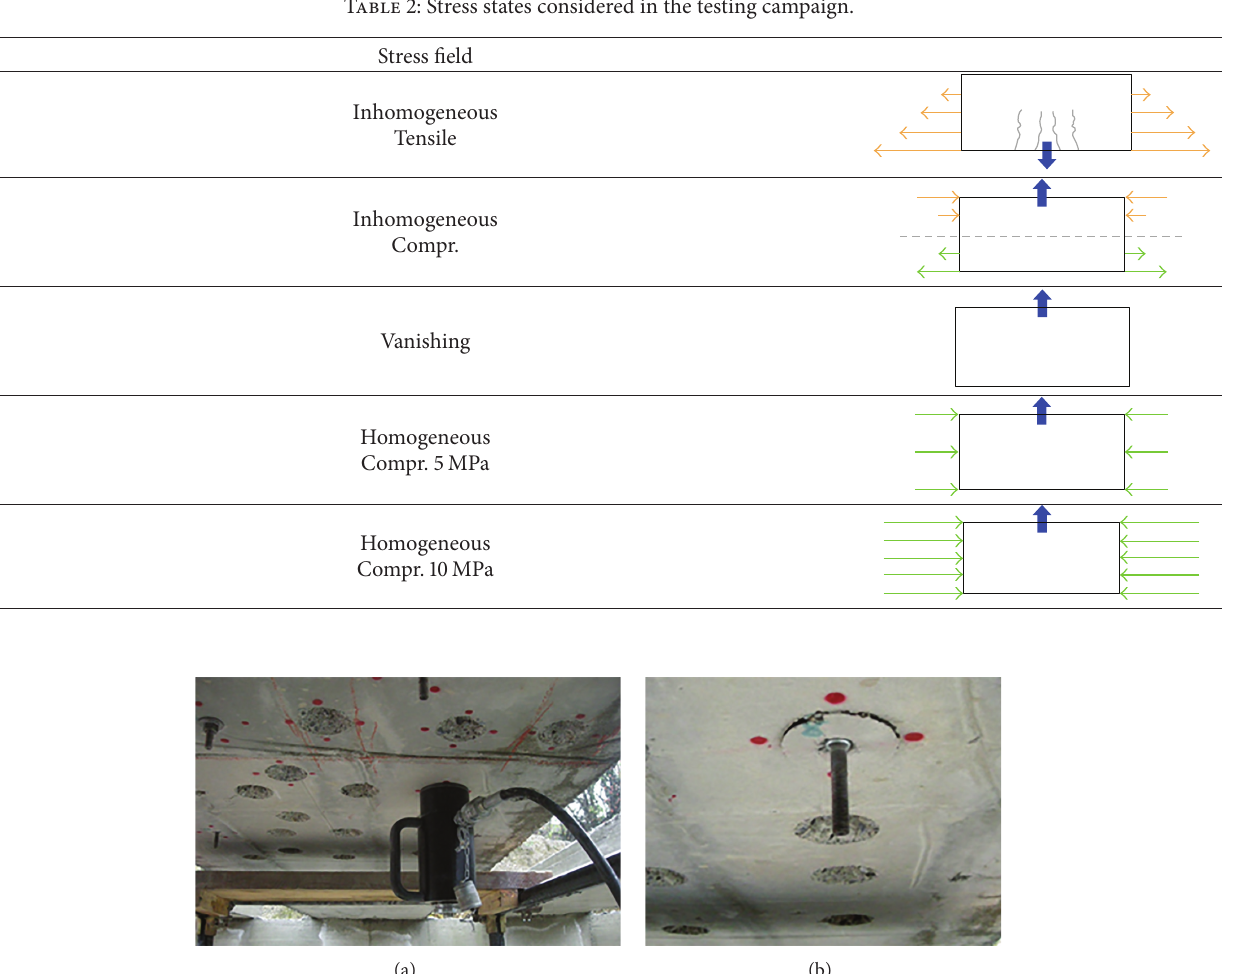
Figure 11: Pull-out in tensile stress states (intrados of the slab of Figure 10); (a) general view of the intrados; (b) detailed view of the extracted